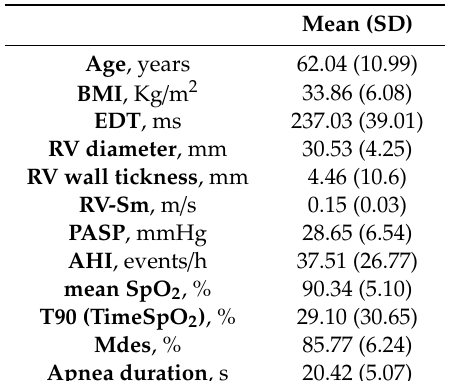
Table 1. Patient characteristics, nCRP, and ETT evaluations at admission.